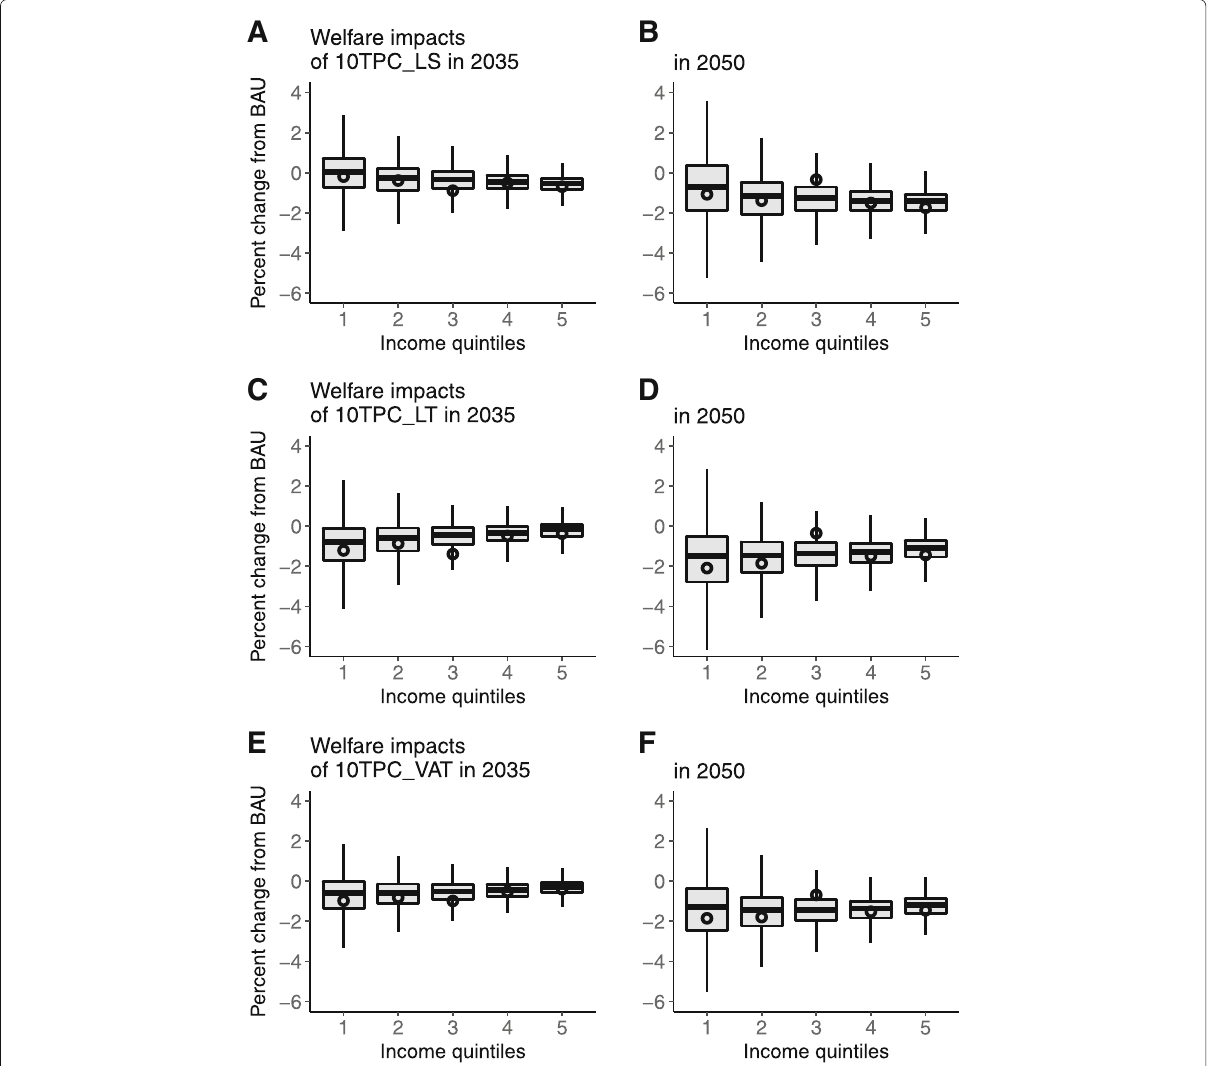
Fig. 3 Distribution of welfare impacts across income quintiles for different revenue recycling schemes (10TPC target) in 2035 ( a , c , and e ) and 2050 ( b , d , and f )